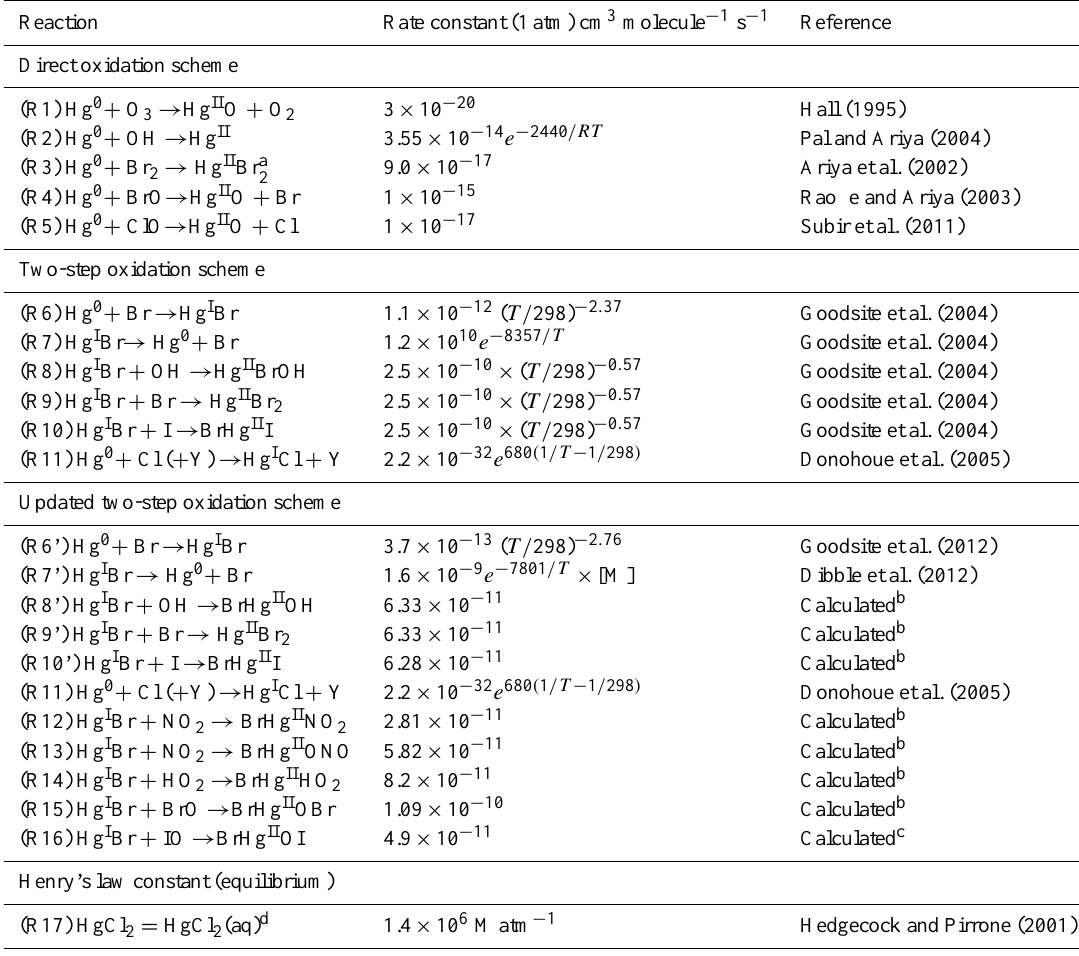
Table 1. Gas-phase mercury–halogen reactions used in the photochemical box model.